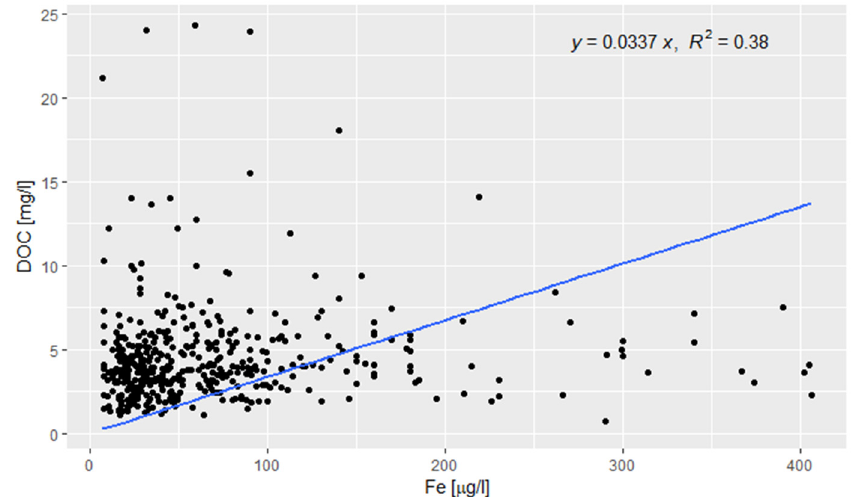
Figure 2. The relationship between the measured concentrations of DOC and dissolved Fe in Bulgarian surface waters.